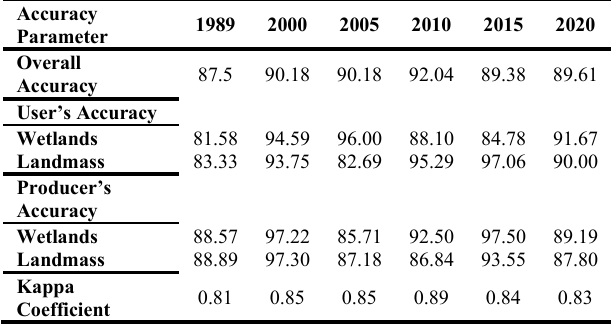
Table 2 . Accuracy chart for image classification.